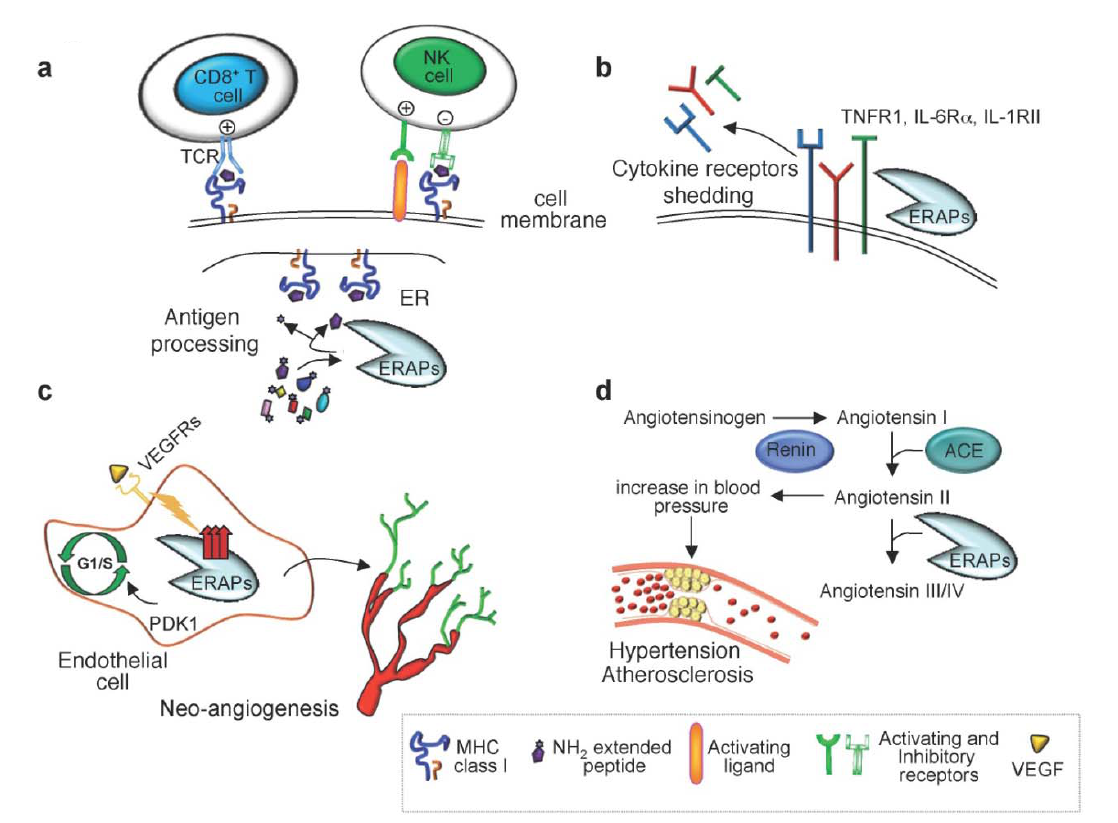
Figure 1. Schematic representation of the multifunctional properties of endoplasmic reticulum (ER) aminopeptidase 1 (ERAP1) and ERAP2. ERAP1 and ERAP2 (ERAPs) are involved in a variety of biological processes including ( a ) the final trimming of peptides in the endoplasmic reticulum (ER) for presentation on MHC class I molecules; ( b ) shedding of several cytokine receptors; ( c ) post-natal angiogenesis; ( d ) regulation of blood pressure. For details see